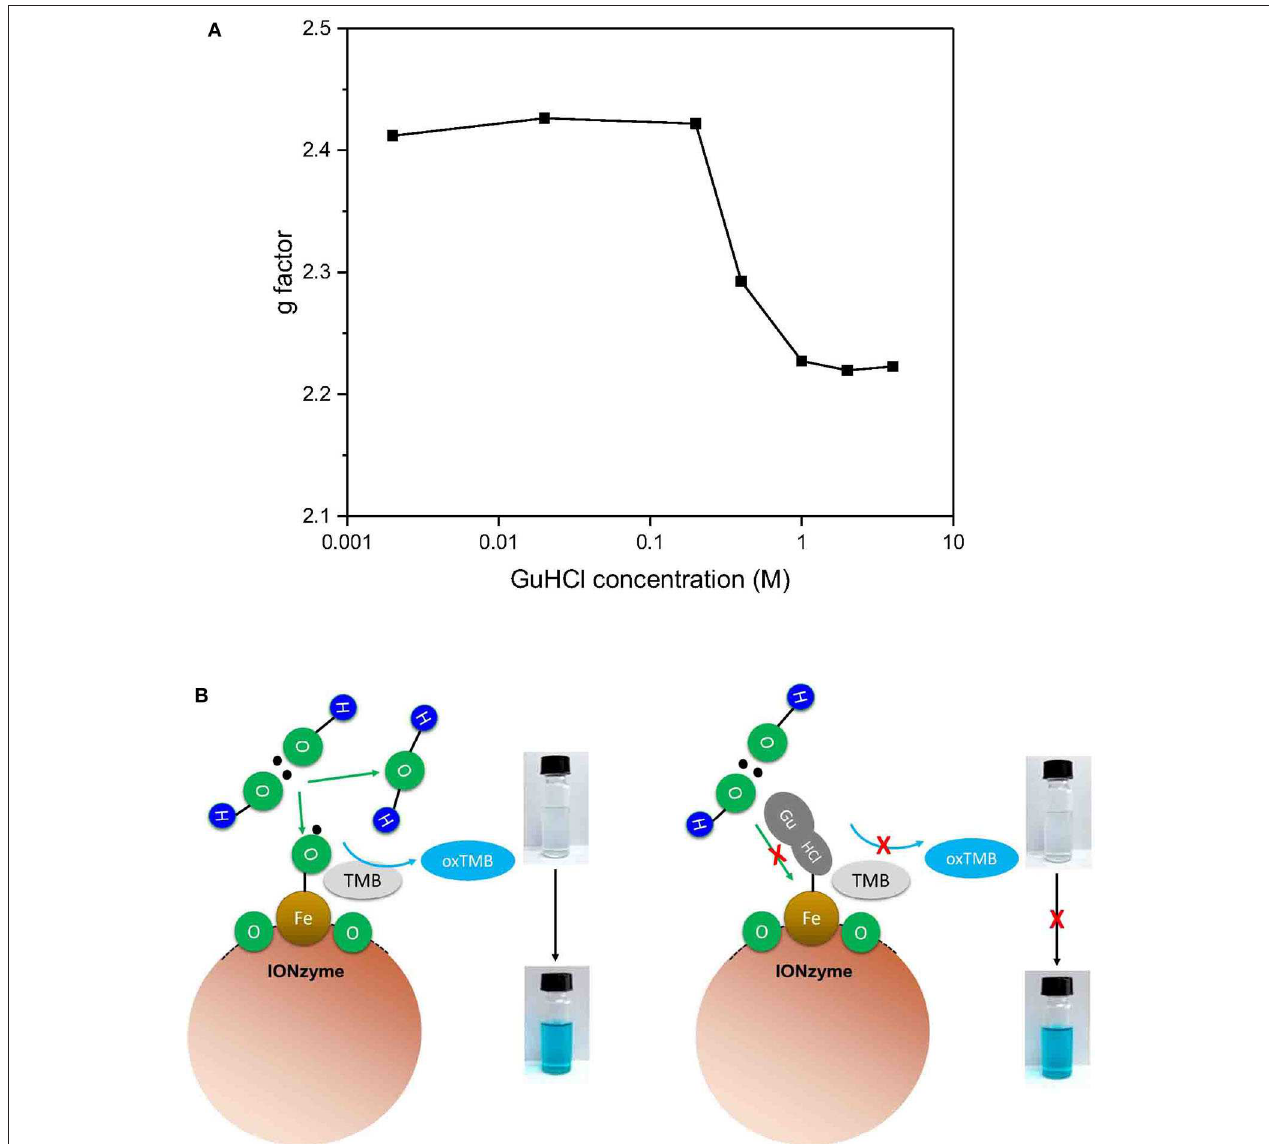
FIGURE 5 | Mechanism of the peroxidase reaction catalyzed by IONzyme. Electron spin resonance spectroscopy was used to analyse the interaction between IONzyme and GuHCl in sodium acetate buffer. The change in the g factors of IONzymes in different concentrations of GuHCl (A) . A putative Scheme of IONzyme catalytic reaction (B)